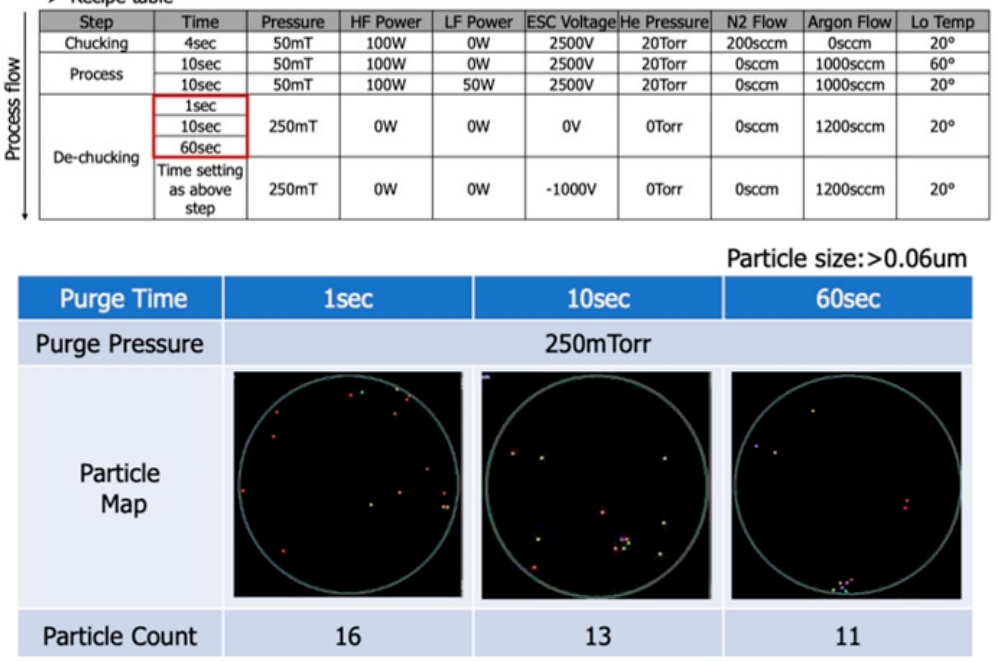
Figure 22. Particle distribution results under a gas purge discharge pressure of 250 mTorr for different discharge times.